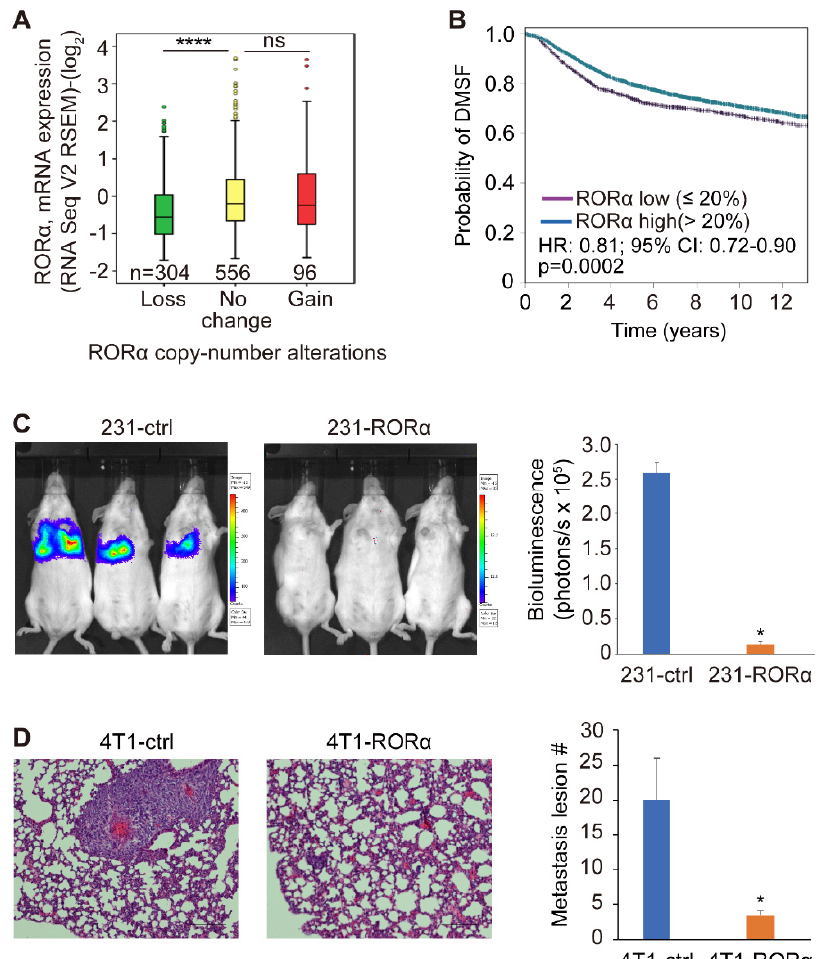
Figure 5. ROR α expression inhibits breast cancer metastasis in mice. ( A ) Reduction of ROR α expression was negatively associated with LOH in human breast cancer tissue, n = 860, **** p < 0.0001, one-way ANOVA test. ( B ) Kaplan-Meier survival analysis showing reduced ROR α mRNA level is associated with short distant recurrence-free survival, n = 6365. ( C ) IVIS images (left) and quantification data (right) showing lung colonization of control and ROR α -expressing MDA-MB-231-luc cells in SCID mice; results are presented as mean ± SEM; n = 6, * p < 0.05, student’s t-tests. ( D ) HE staining (left) and quantification (right) of metastatic lesions of 4T1 cells in the lung; results are presented as mean ± SEM; n = 4, * p < 0.05, student’s t-tests. Bar: 100 µm.